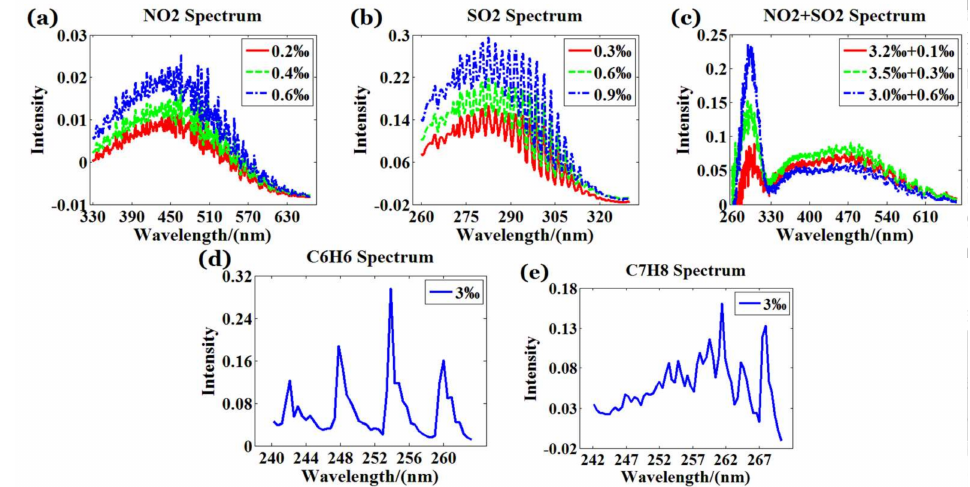
Figure 5. One-dimensional characteristic curve of test gases ( a ) NO 2 ( b ) SO 2 ( c ) NO 2 + SO 2 ( d ) C 6 H 6 ( e ) C 7 H 8